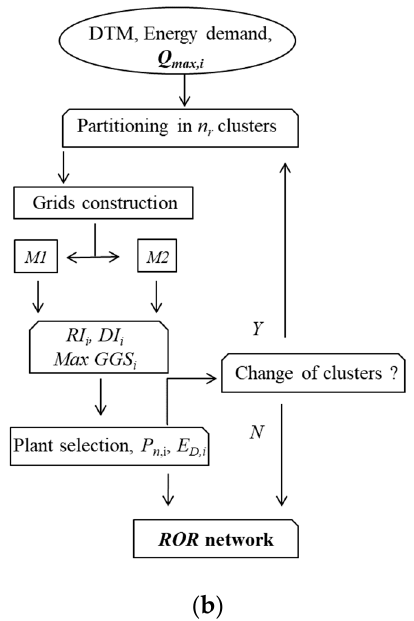
Figure 2. Flow chart ( a ) Poli-Hydro model. The modeling procedure, and tools are given according to 7 categories, i.e., domain (e.g., hydrology, cryosphere), tools (e.g., hydrological model, snow melt model), functions (e.g., snow melt M s as a function of temperature, and radiation M s ( T , G ), etc.), necessary data from field surveys or other sources (ice melt from stakes, ice volume loss from topographic methods, earth observation from space EOS , etc.), data (weather, snow depth, SCA from remote sensing, etc.), model outputs (e.g., ice melt in time and space M i ( t , s )), and model accuracy (e.g., Bias, NSE). Division in present, and future (projections) reported. Dashed lines indicate methods/data that could be used generally as alternatives in high altitude catchments, but were not used here (e.g., snow depth data were not available, etc.). In bold, most important model outputs. T ( t ) is daily temperature, P ( t ) daily precipitation, Q ( t ) is daily observed discharge at the outlet section, Q m ( t ) is daily modeled discharge at the outlet section. M i (t,s) is daily ice melt in a given place (cell) s , M s ( t , s ) is daily snow melt, q (t,s) is daily runoff in cell s , h ice (t,s) is daily ice depth, and V ice (t,s) daily ice flow velocity. SCA is the snow covered area. SWE is the snow water equivalent. ICA is the ice covered area, IWE m is the water equivalent of ice melt. NSE is the Nash–Sutcliffe efficiency. DTM is the digital terrain model. T f ’ ( t ), P f ’ ( t ) are (future/projected) the temperature and precipitation from GCMs before downscaling (biased); T f ( t ), P f ( t ) future daily temperature and precipitation after downscaling (unbiased). Q f ( t ) future projected discharges. ( b ) Poli-ROR iterative algorithm. Poli-ROR takes as input DEM, energy demand, and Q max , I calculated at each site i using outputs from Poli-Hydro (Section 4.3). Poli-ROR is performed by (i) area subdivision, or clustering, with the number of clusters giving the number of plants, and (ii) mini-grid construction, repeated iteratively until convergence (Section 4.5). M1 is Min-LCOE approach, M2 is Max-Connection approach. GGS i is grid generation score at each cluster/plant (Equation (8)), DI i demand indicator (Equation (9)), and RI i resource indicator (Equation (11)) thereby. P n , i is power at each cluster/plant i (Equation (2)), and E D , i energy demand thereby (Equation (3)).